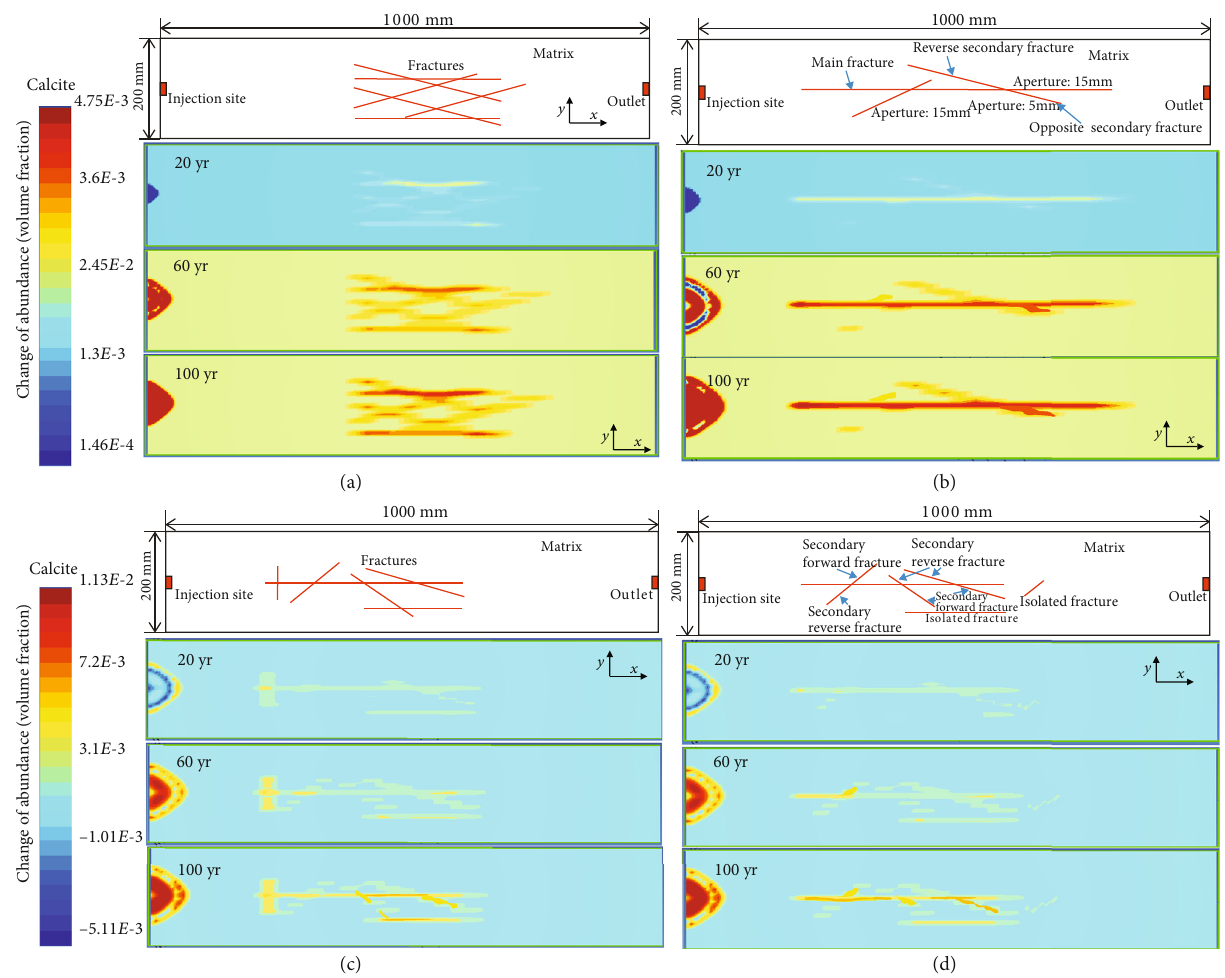
Figure 9: Spatial distribution of mineral abundance for prescribed fracture patterns after simulations. (a) Changes of calcite abundance in cross section of Pattern 1 (net-shaped fractures) during fl uid injection; (b) changes of calcite abundance in cross section of Pattern 2 (variable aperture); (c) changes of calcite abundance in cross section of Pattern 3 (variable angle); (d) changes of calcite abundance in cross section of Pattern 4 (variable